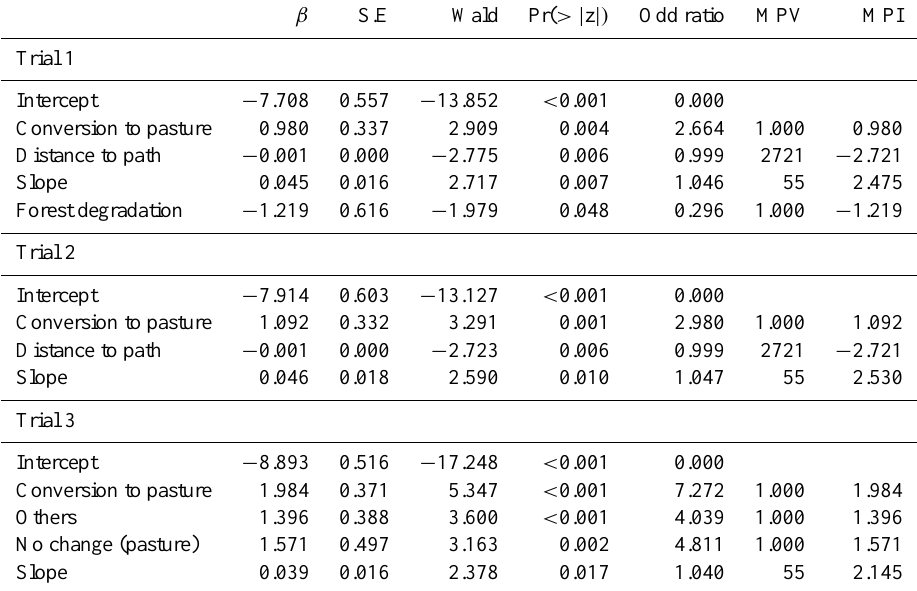
Table 3. Rare event logistic regression with landslide sample of 1995 for three trials, each of them having a different sample of non event; logistic coefficient ( β) ; standard error on β (S.E); Wald statistic; variable significance (Pr( > | z | ) ); Odd ratio; maximum value of explanatory variable in dataset (MPV); measure of parameter importance